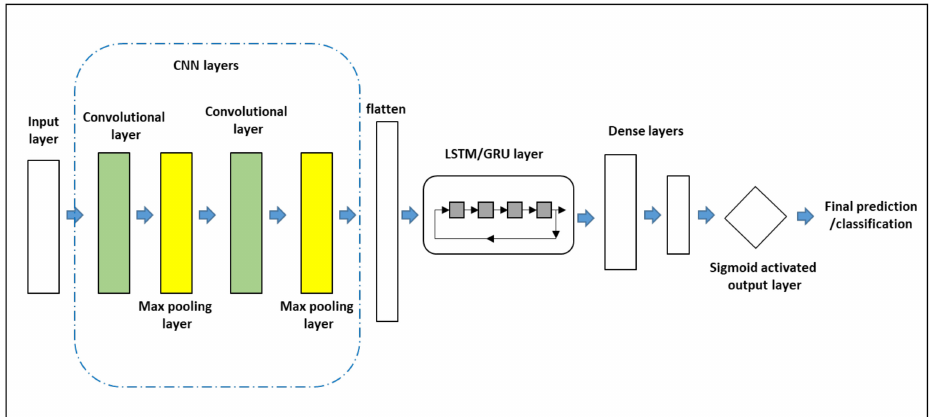
Figure 4. Overview of the CNN-LSTM and CNN-GRU hybrid model